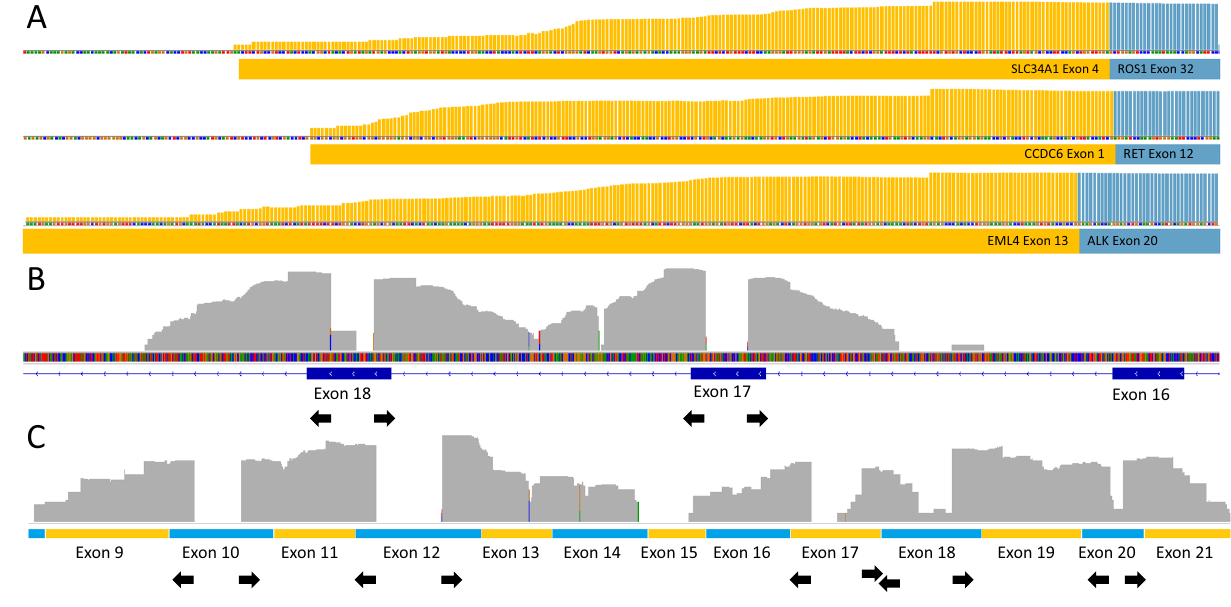
Figure 4. Technical validation of ATOM-Seq RNA based fusion protocol. ( A ) An FFPE fusion reference material containing 3 certified fusions was used to demonstrate fusion detection. Reads were mapped to contigs representative of the fusions, demonstrating reads spanning the EML4-ALK, CCDC6-RET, and SLC34A2- ROS1 fusions. ( B , C ) A total nucleic acid sample was used as starting material to the fusion protocol. ( B ) Shows DNA derived reads mapped to hg38 spanning exon–intron boundaries. ( C ) Shows reads which map to JAK1 (NM_001320923.1). The exons and orientation of the primers are shown, this demonstrates successful capture of cell-free RNA molecules as shown by the exon junction spanning reads. All read depths are shown in a log10